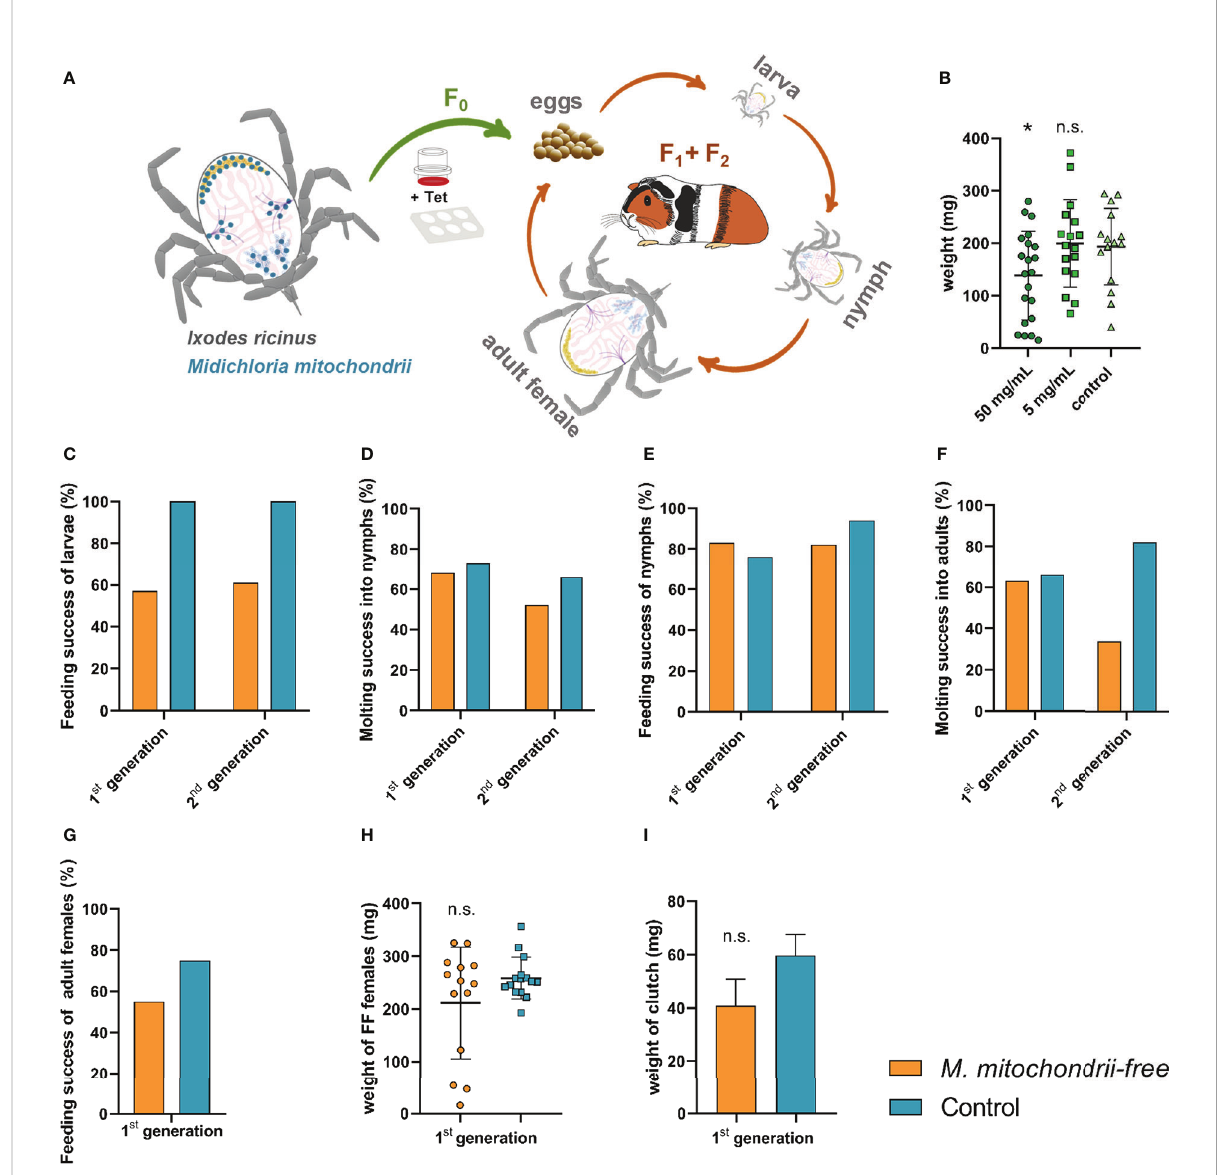
FIGURE 3 Effect of the absence of Midichloria mitochondrii on tick engorgement and development across two generations. (A) A scheme depicting the production of M. mitochondrii -free strain of I. ricinus ticks. The ex vivo membrane feeding is indicated by a feeder and a 6-well plate; Tet, tetracycline. The green arrow indicates a reduction in M. mitochondrii levels in generation zero, while the orange arrows indicate the propagation of apo-symbiotic I.ricinus lineage upon M. mitochondrii elimination. The blue dots in the cartoon of unfed I. ricinus female (top left) indicate tissue tropism of M. midichloria , according to (Olivieri et al., 2019). (B) Weights offully engorged I. ricinus females upon blood feeding tetracycline-supplemented blood meal via ex vivo membrane feeding. Stock concentrations of tetracycline are shown. Mean and SEM are shown, n ≥ 15; *p < 0.05; n.s., not signi fi cant. (C) Success feeding rate of M. mitochondrii -free larvae in two generations subsequent to adult I. ricinus clearance. (D) Molting success of these larvae into nymphs. (E) Feeding success rate of M. mitochondrii -free nymphs in two generations subsequent to adult I. ricinus clearance. (F) Molting success of these nymphs into adults. (G) Feeding success rate of M. mitochondrii -free adults in a generation subsequent to adult I. ricinus clearance. (H) Weights of these M. mitochondrii -free I. ricinus adult females upon in vivo engorgement. (I) Weights of egg clutches laid by 1 st generation M. mitochondrii -free I. ricinus females. (B, H, I) Mean and SEM are shown. Original numbers to the bar graphs are shown in Supplementary Table